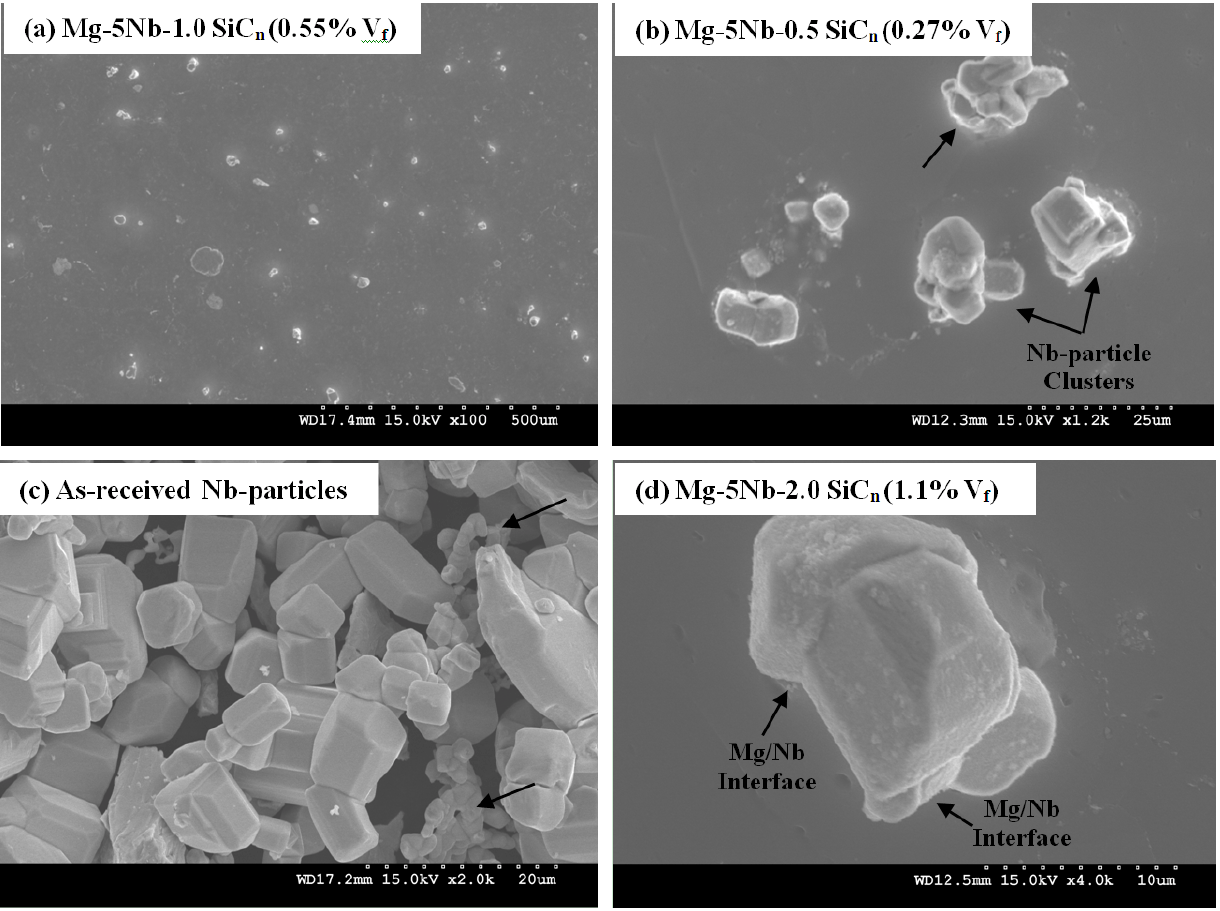
Figure 2. Representative SEM micrographs showing: ( a ) uniform distribution of Nb particles in Mg-5Nb-1.0 SiC (0.55% V ); ( b ) high magnification image of clustered n f Nb-particles (arrow) in Mg-5Nb-1.0 SiC (0.27% V ); ( c ) image of as-received Nb particles n f that are cuboidal in shape with varying sizes; ( d ) high magnification image of Nb particle in Mg-5Nb-2.0 SiC (1.10% V ) showing good interfacial bonding between Mg and Nb n f (arrow) with no interfacial reaction